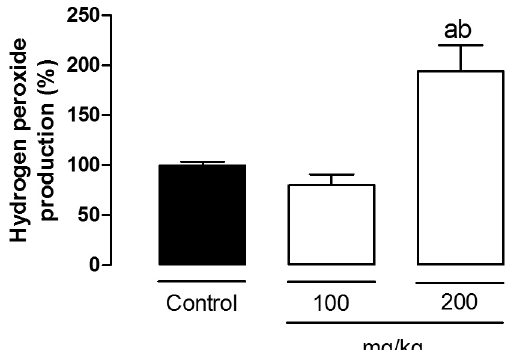
FIGURE 6 - Hydrogen peroxide production of resident macrophages from mice fed regular chow (Control Group), treated with 100 mg/kg b.w. of CLD (Group 100), and 200 mg/kg b.w. (Group 200). a p<0.001 compared to Control. b p<0.001 compared to 100. Results are presented as % relative to